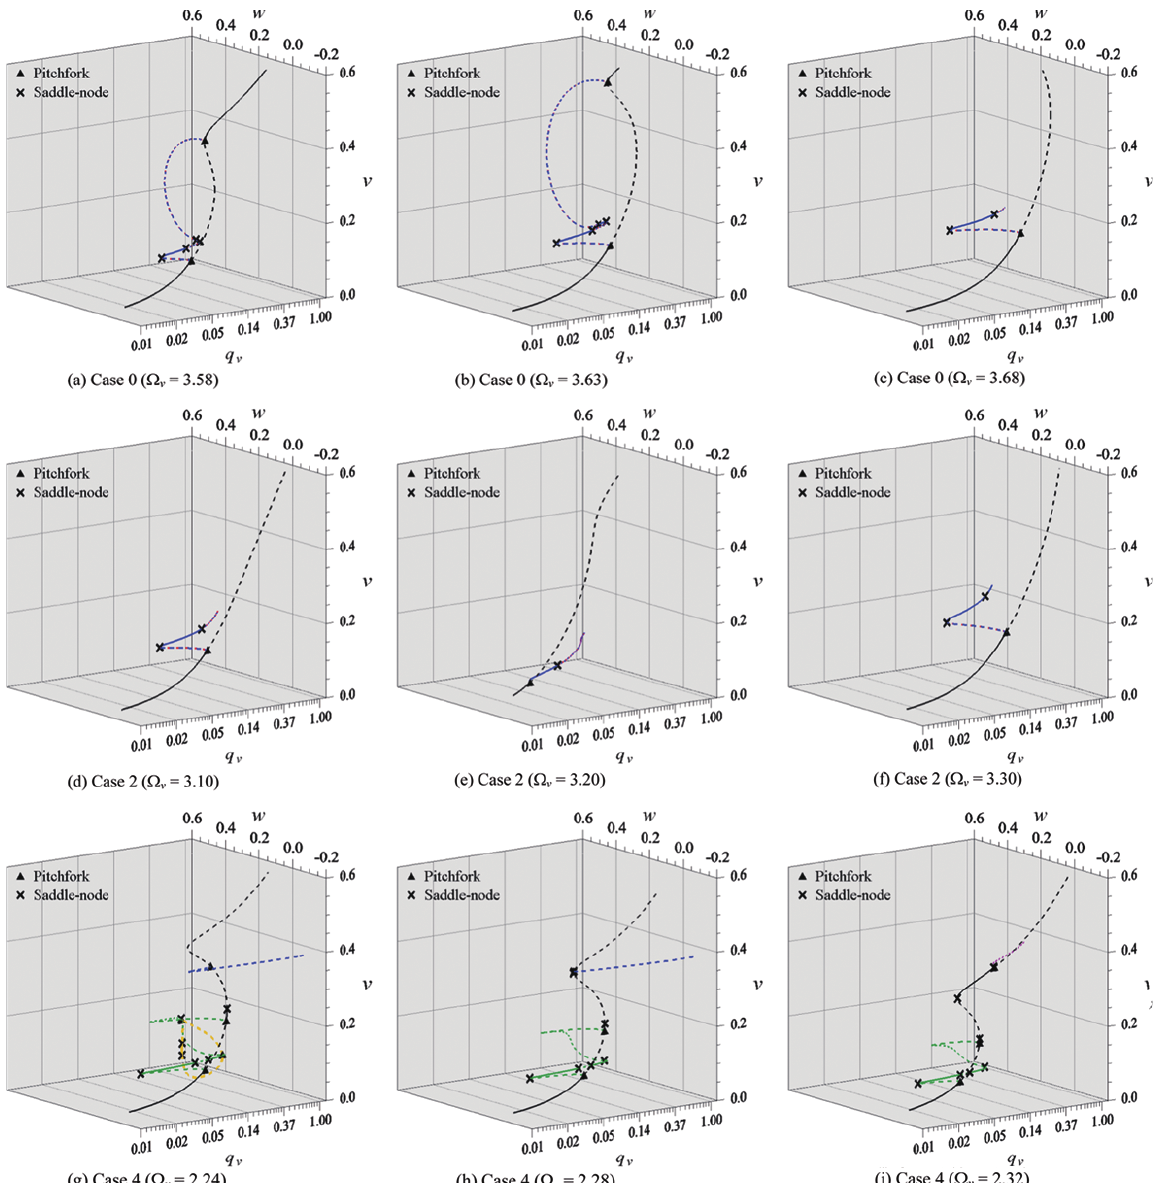
Fig. 16. Bifurcation diagram in the v − w − q v space, considering an axial static load and taking the lateral harmonic excitation magnitude as control parameter. For example, in Fig. 15(b) for P s /P cr = 0.15, the pitchfork bifurcation PF1 moves downward along the previ- ously stable resonant branch and new saddle-node bifurcations arise along the bifurcated paths, leading to several planar and non-planar coexisting attractors in some frequency ranges. As the load increases still further and the nat- ural frequency approaches zero, most of the bifurcated paths become unstable and the bifurcation point PF1 moves downwards leading to frequency regions with no stable solutions, as observed in Fig. 15(d). Also, the influence of the load on the backbone curve (see Fig. 2(b)) changes the resonant behavior from hardening to softening. In addition, Fig. 16 shows the diagrams of bifurcations in the v − w − q v space for three different values of the lateral excitation frequency and for each of the three axial load magnitudes (i.e. Case 0, Case 2 and Case